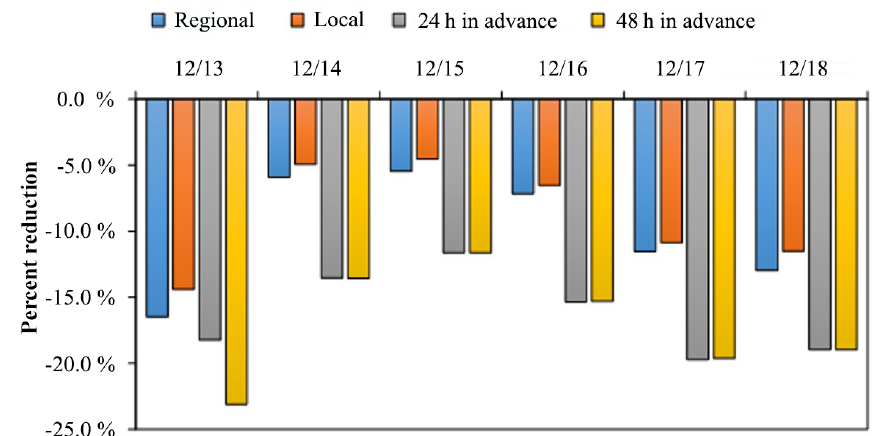
Figure 18. Decline rates of PM 2 . 5 daily average concentrations in Jiaxing under different